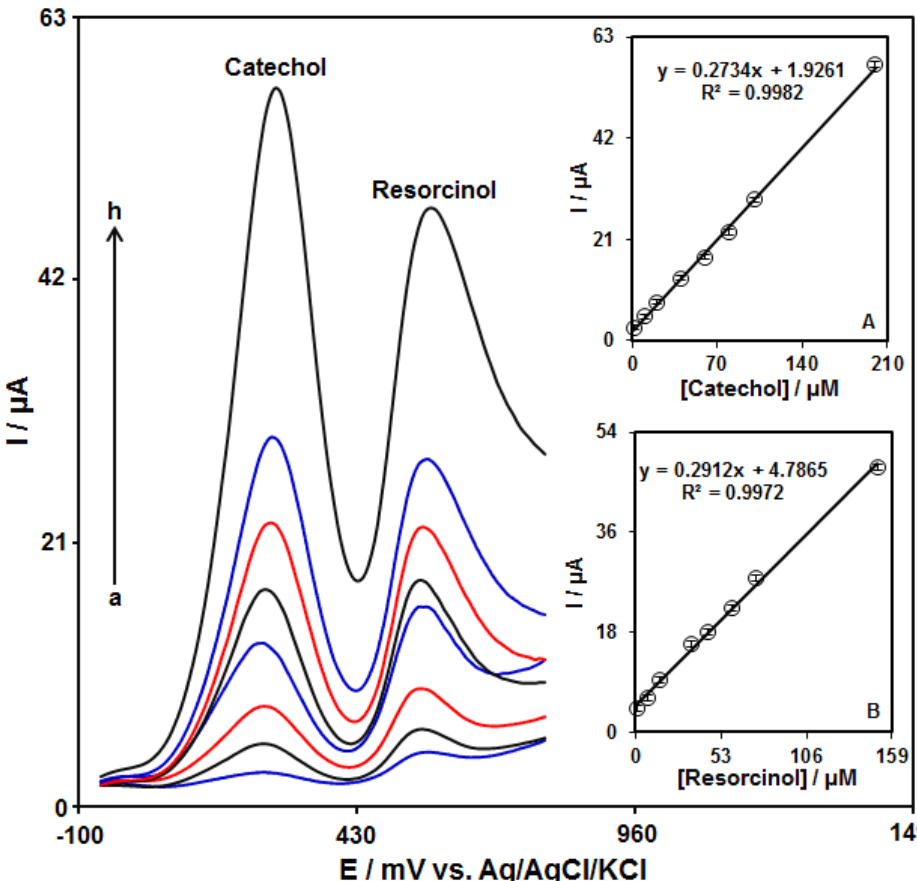
Figure 7. DPV responses of GO–PAMAM/ILCPE sensor in a 0.1 M PBS (pH = 7.0) with various concentrations of catechol (a: 1.0, b: 10.0, c: 20.0, d: 40.0, e: 60.0, f: 80.0, g: 100.0, and h: 200.0 µ M) and resorcinol (a: 1.0, b: 7.5, c: 15.0, d: 35.0, e: 45.0, f: 60.0, g: 70.0, and h: 150.0 µ M). Insets ( A , B ): plot of the correlation of peak current with target concentration.